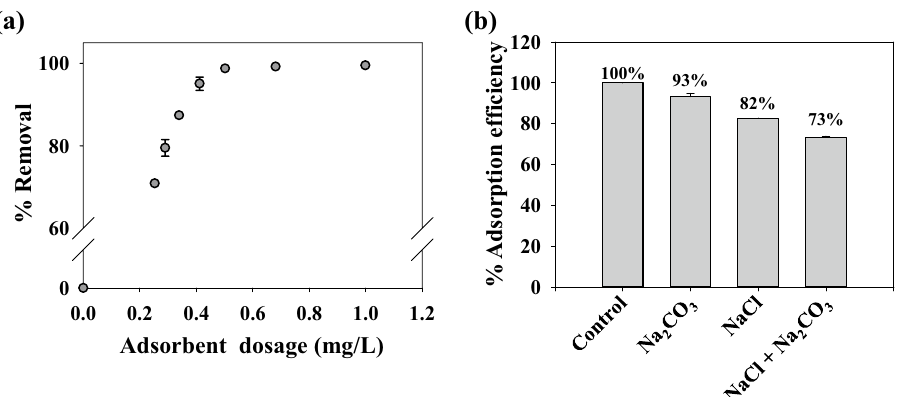
Figure 7. ( a ) Effect of adsorbent dosage on %removal of MB, at C 0 = 70 ppm. ( b ) Effect of salinity on the adsorption of MB onto N